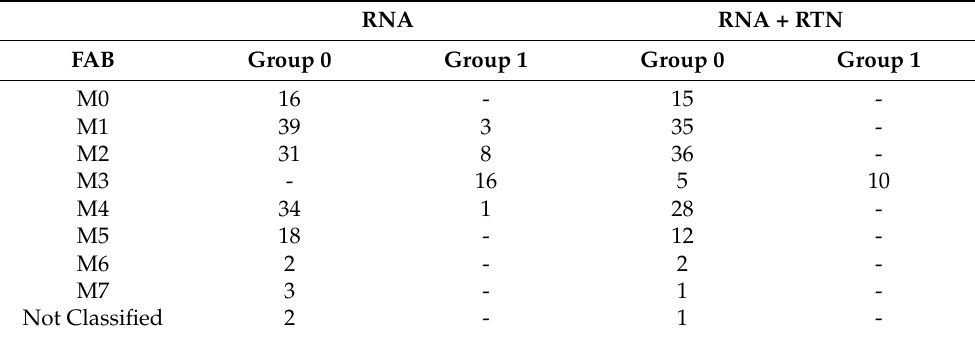
Table 2. The FAB division of patients in the 2 groups. The BIRCH algorithm was used to divide the patients into 2 groups (see text), and the number of patients with each FAB type is shown. The likelihood of finding all patients in group 1 in M3 of the RNA + RTN analysis was calculated ( p = 0.00371 for Newton’s